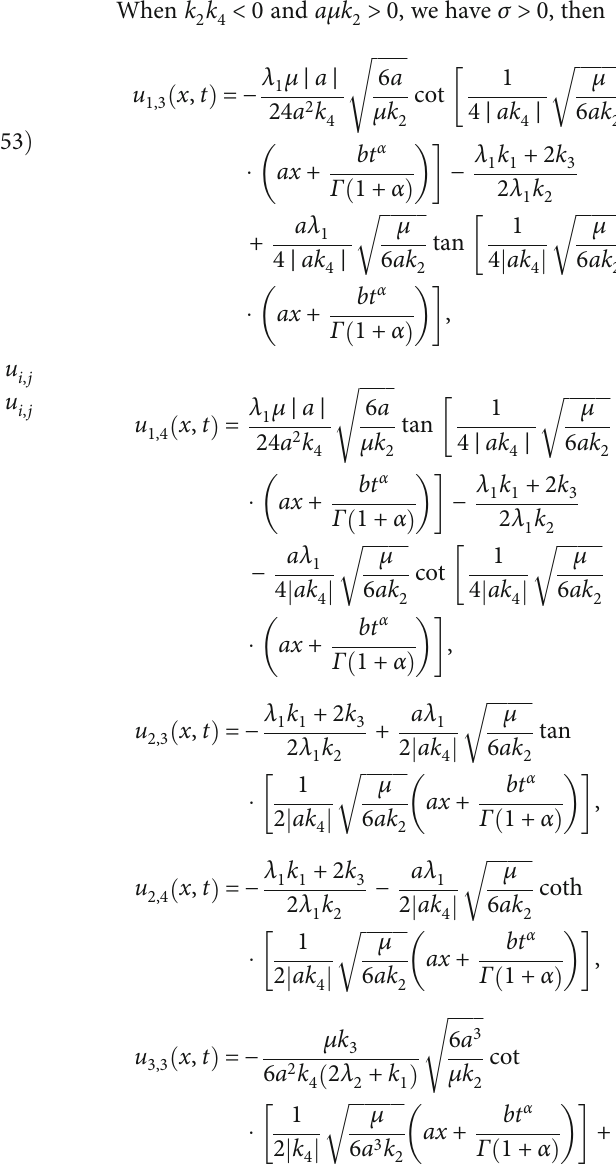
ffiffiffiffiffiffiffiffiffi μ ffiffiffiffiffiffiffiffiffi μ ffiffiffiffiffiffiffiffiffiffiffi